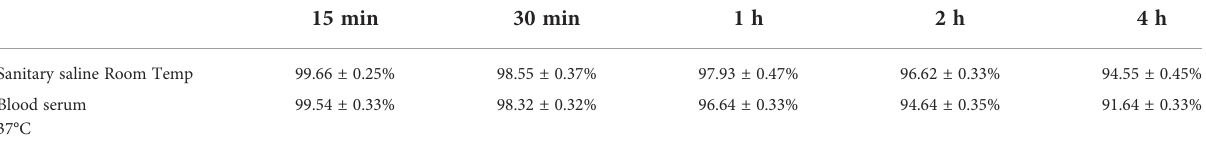
TABLE 1 In vitro stability of 68 Ga-DOTA-IBA under different